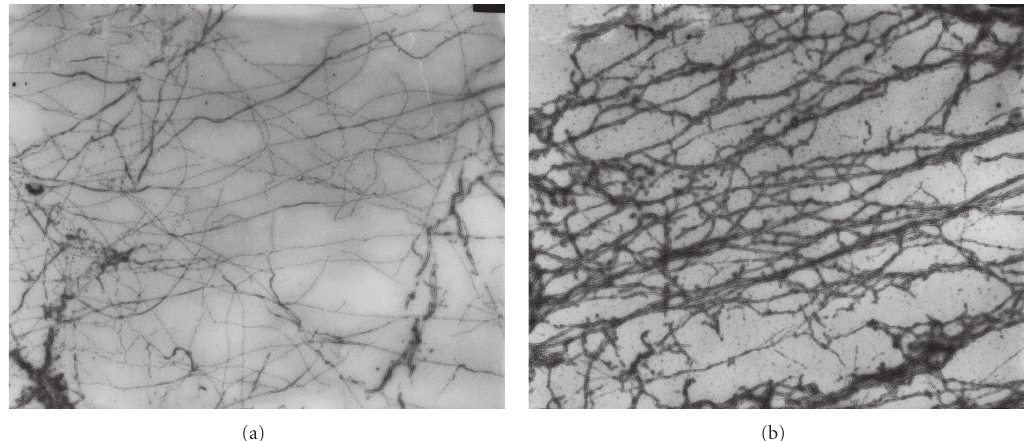
Figure 6: Electron microscopy of F-actin ± Hsp27. Negative staining images of 2 μ M actin (a) and 2 μ M actin plus 6 μ M Hsp27 (b) incubated overnight in F-bu ff er. Magnification equals x 15960. Images courtesy of Dr. Katsuhide Mabuchi. significant dissolution of the filaments, indicating no